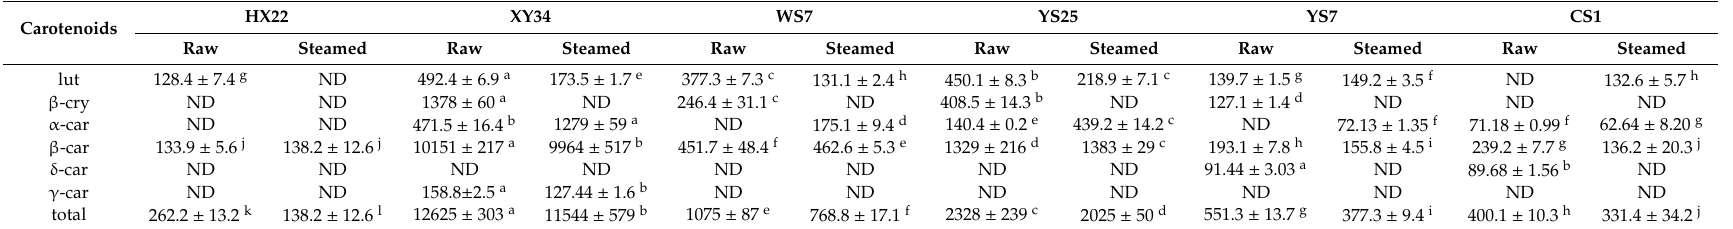
Table 1. Changes of carotenoids profiles in sweet potato roots (SPRs) after thermal